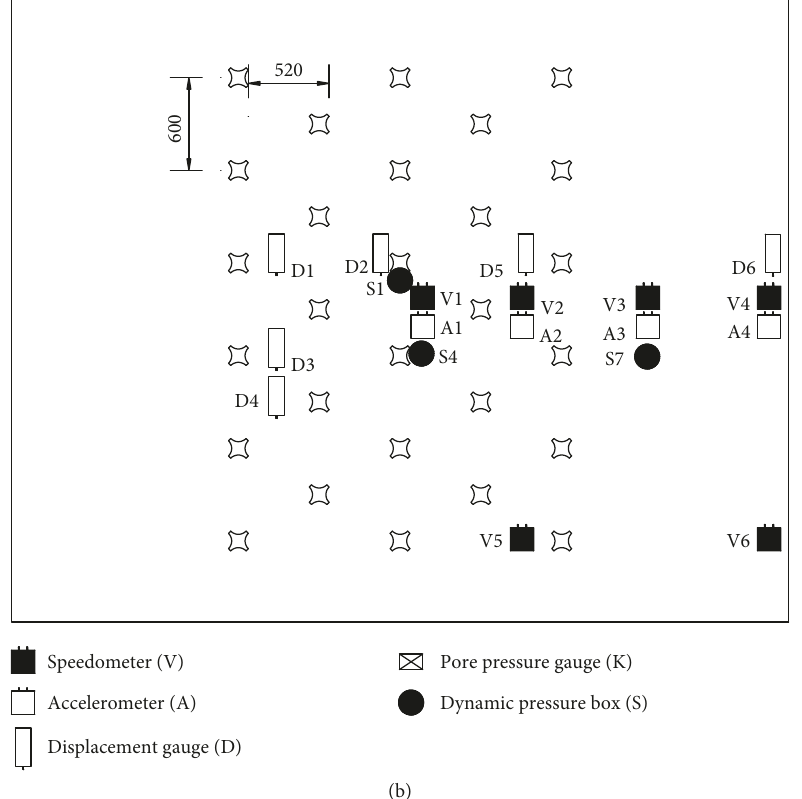
Figure 3: Layout of test instrument (unit: mm): (a) front view; (b) top